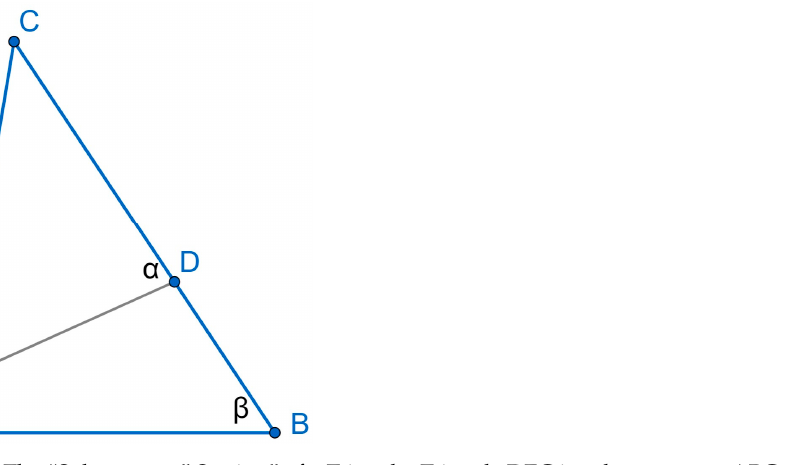
Figure 4. Pappus’ “Theory of Means”. Based on [38] (p. 569). Interval BZ, as side of triangle BZD, which is subcontrary to ABC, shows the role of subcontraraiety in the construction of the har- monic mean of AD and DC. The inverse or subcontrary relation between the arithmetic and harmonic means is reflected in musical theory in that the interval from C to F, a fourth, is able to be under- stood as an inversion of the fifth , F to C, in which the C is now below rather than above the root note F. The significance of this structure for Hegel is clear. Of the sequence 6, 8, 9, 12, the extremes can be understood as qualitatively different instantiations of the same note, while 8 and 9, while dividing different intervals, can be considered the same when